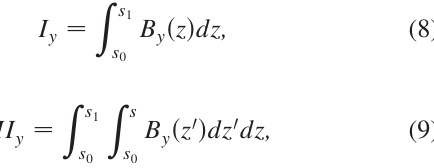
FIG. 7. Top: Optimized field at the pole tip B (cid:4) versus engineer- p ing current density. Bottom: Load lines for wiggler magnets with ¼ y ¼ z ) and a gap 18 mm. For example, a coil width ( 0 : 3 (cid:2) w c c in the bottom plot, we find that an engineering current density ¼ 975 A mm (cid:1) 2 yields a maximum surface field B (cid:4) ¼ 6 T J (cid:4) eng s ¼ 50 mm . The top plot for a Nb-Ti strand at a period length (cid:2) w shows that this wiggler configuration would yield a maximum ¼ 5 : 5 T pole field B (cid:4) p